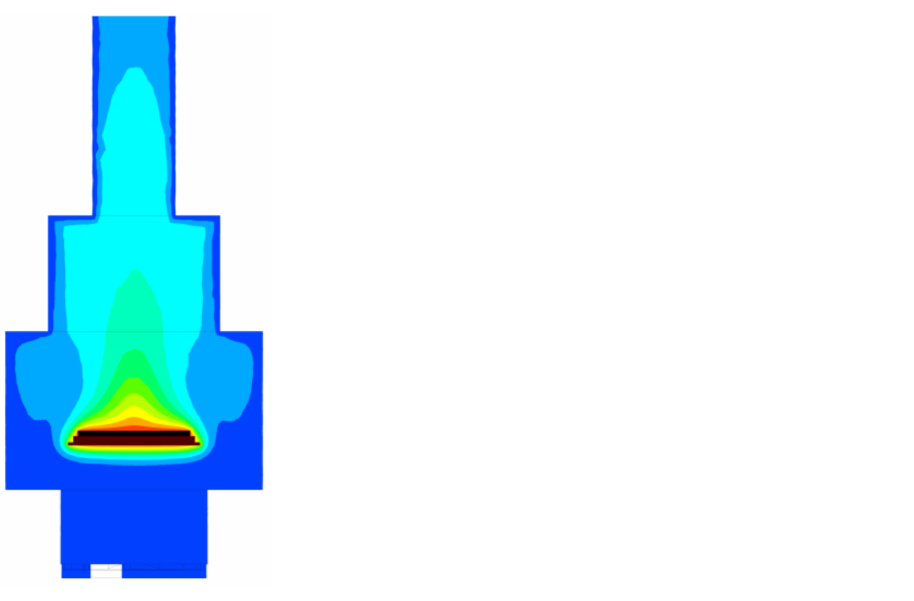
Figure 3. The temperature distribution in the reactor chamber cross-section, obtained at the pressure of 0.5 bar.